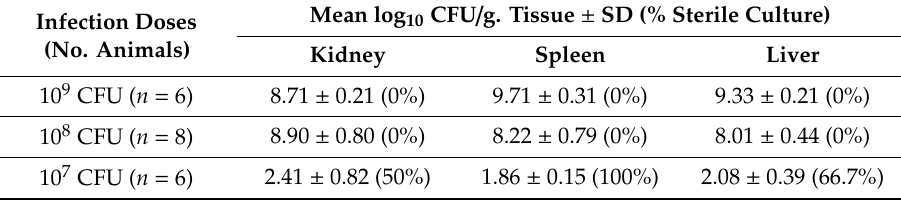
Table 1. ID 95 studies in a murine bacteremia model due to multi-drug resistant (MDR) A. baumannii strain, HUMC1.